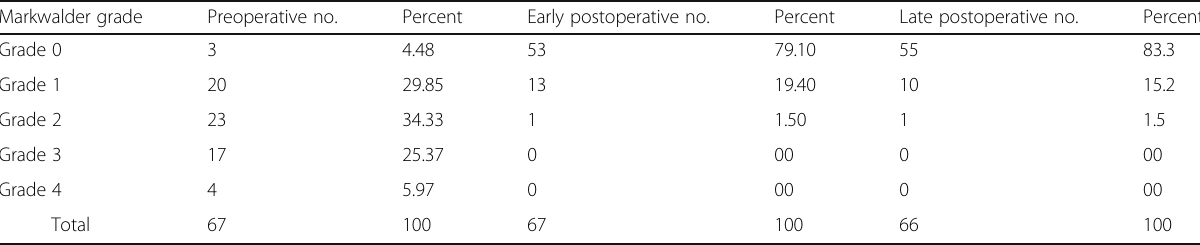
Table 3 Markwalder grading of chronic subdural hematoma patients before and after surgery Markwalder